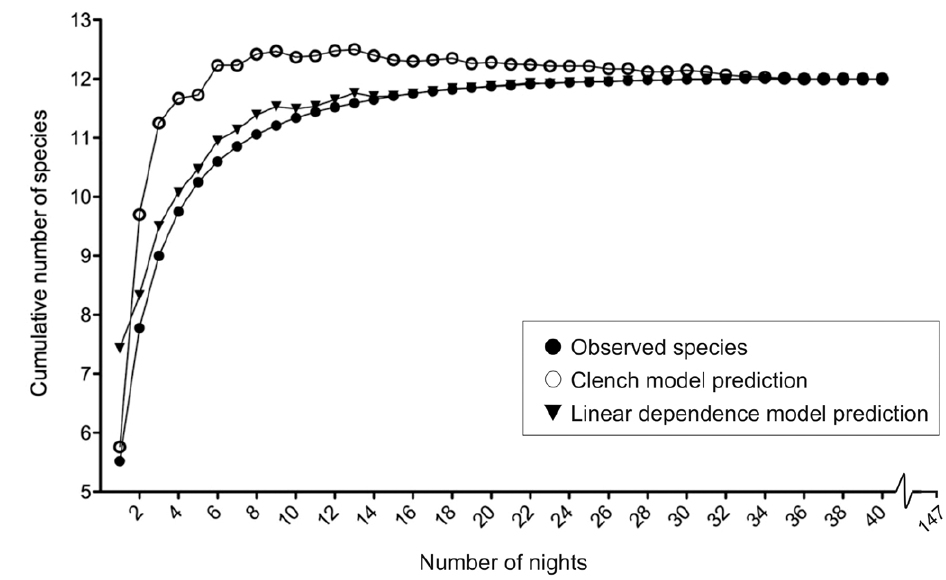
Figure 3. Original and predicted amphibian species accumulation curves (Clench model and Linear dependece model). Results only for visual and acoustic adult surveys (between 2006 and 2015) conducted in the northwestern Buenos Aires